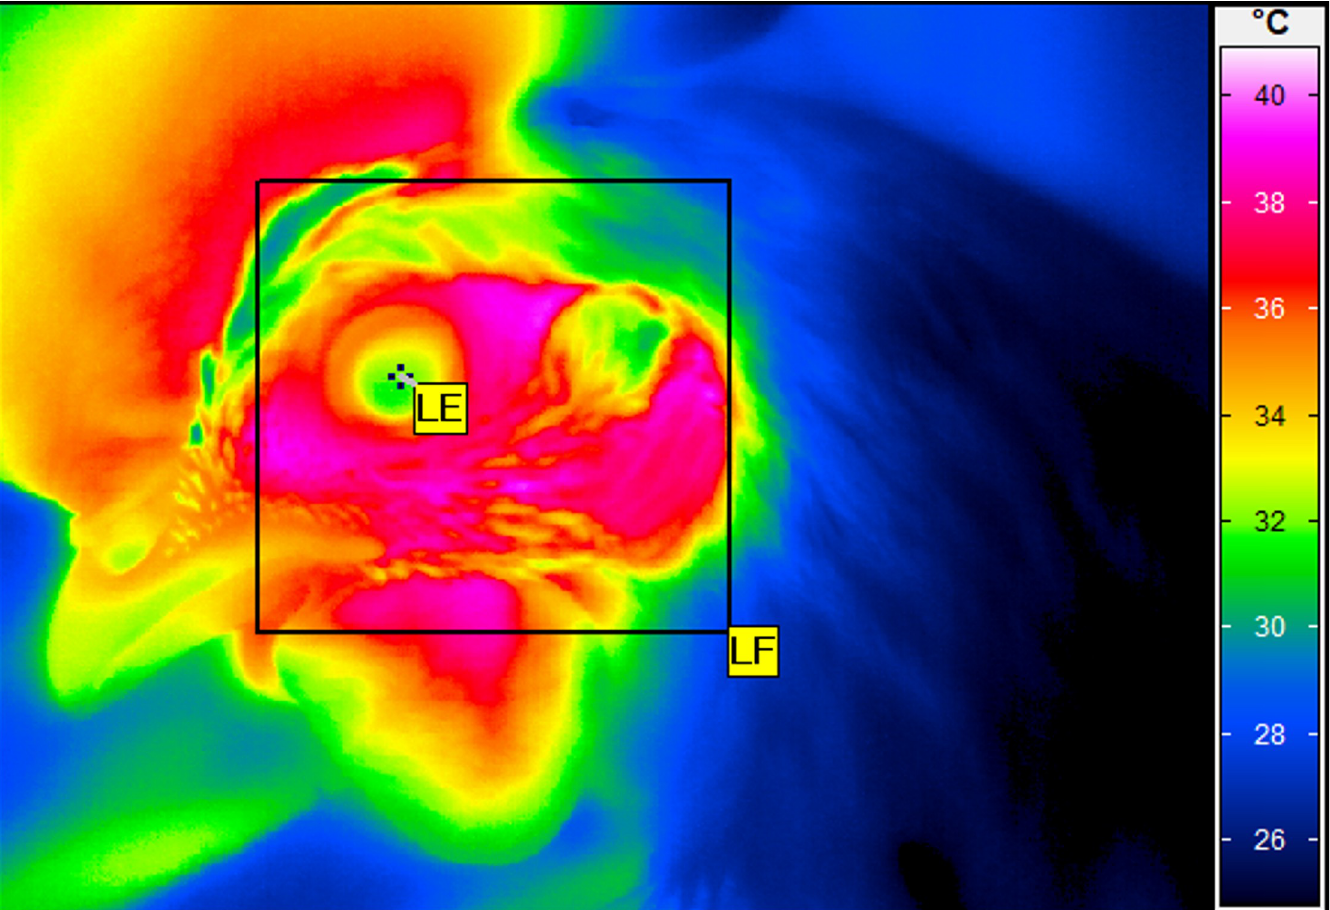
Fig 1. Thermographic image of hen. An example of the thermographic image taken from a White Leghorn hen. The image was taken before tonic immobility testing with indicated the measurement regions of the left face (LF) and left eye (LE).